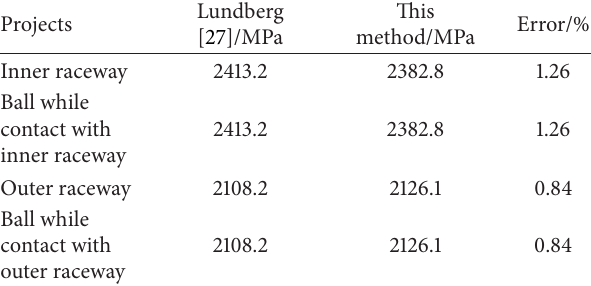
Table 3: Maximum contact stress 𝜎 max of contact